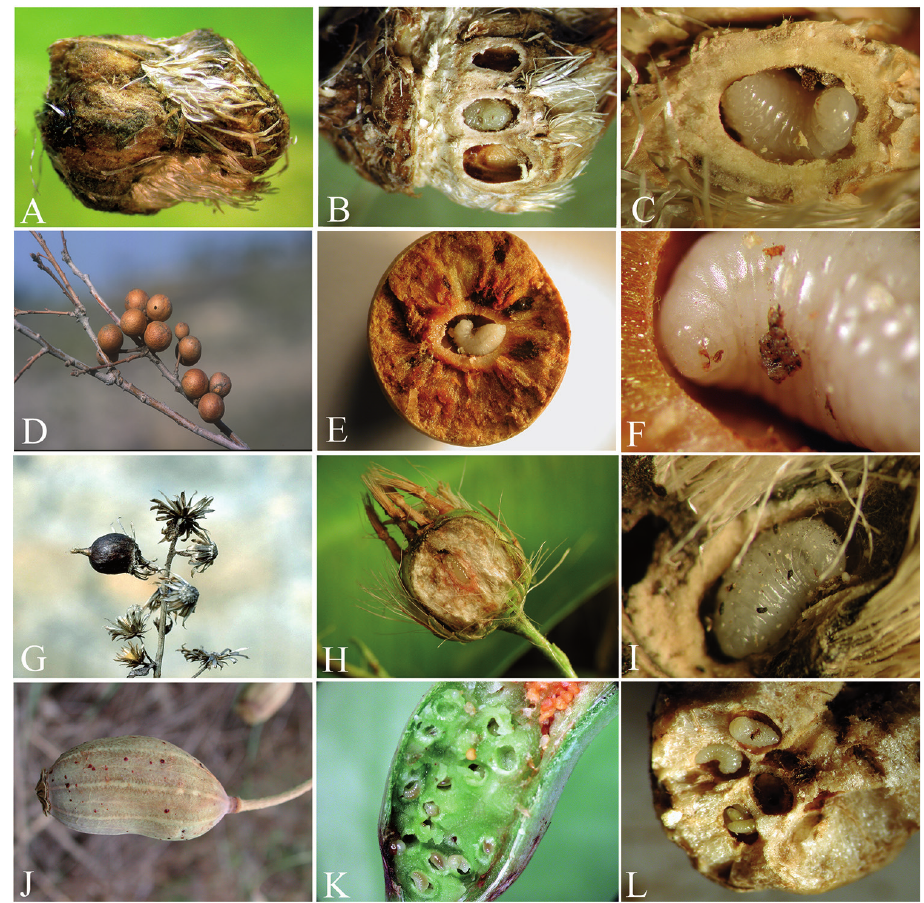
Figure 13. Fully ( A ) and dissected ( B ) galls of Isocolus scabiosae in achenes of heads of Centaurea scabiosa . C . detail of larvae of Ormyrus gratiosus inside cells of I. scabiosae gall D galls of Andricus hispanicus on Quercus pyrenaica E cross-section of gall of Andricus hispanicus with larvae of Ormyrus nitidulus within gall cell F detail of head and thorax in anterior view of larvae of Ormyrus nitidulus within gall cell of A. his- panicus G gall of Myopites limbardae on Inula viscosa H cross-section of gall of Myopites limbardae on Inula viscosa I detail of larva of Ormyrus orientalis within gall cell of Tephritidae on Microlonchus salmanticus J galls of Aylax papaveris on poppy heads K cross-section of poppy head shown cells of galls of A. papaveris L larvae of Ormyrus papaveris with debris of dead host within gall cells of A. papaveris